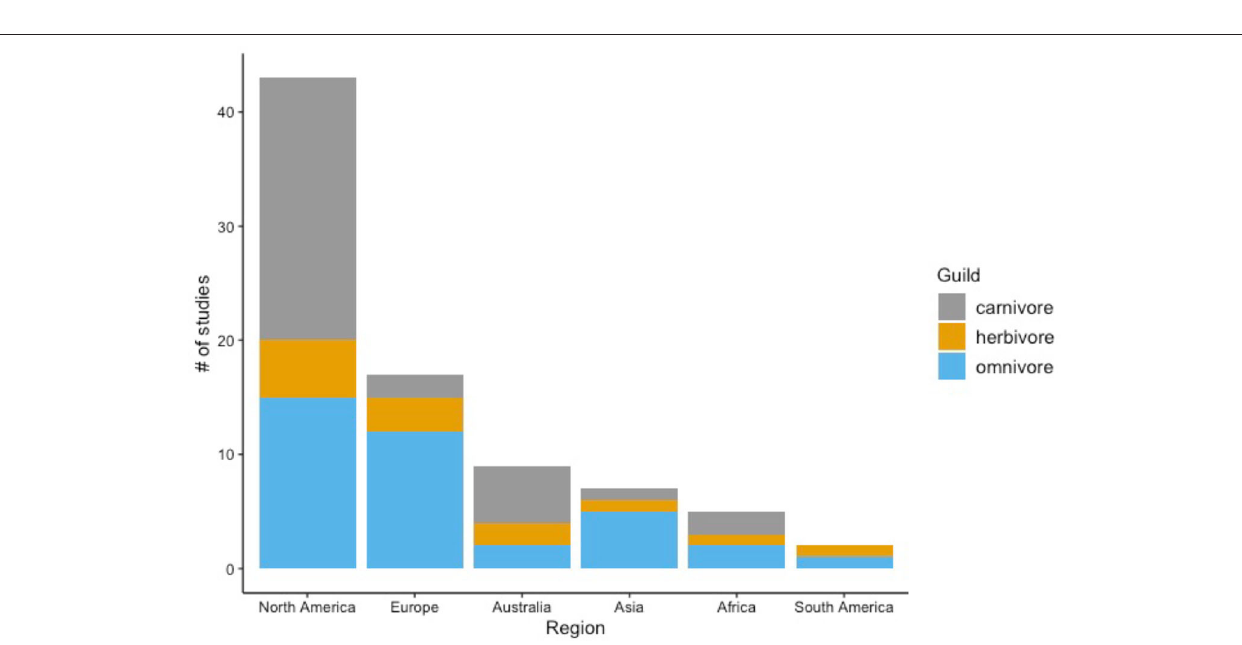
FIGURE 2 | The number of studies that assessed behavioral changes of urban mammals across 6 world continents between 1987 and 2020. Results are categorized by diet guild.